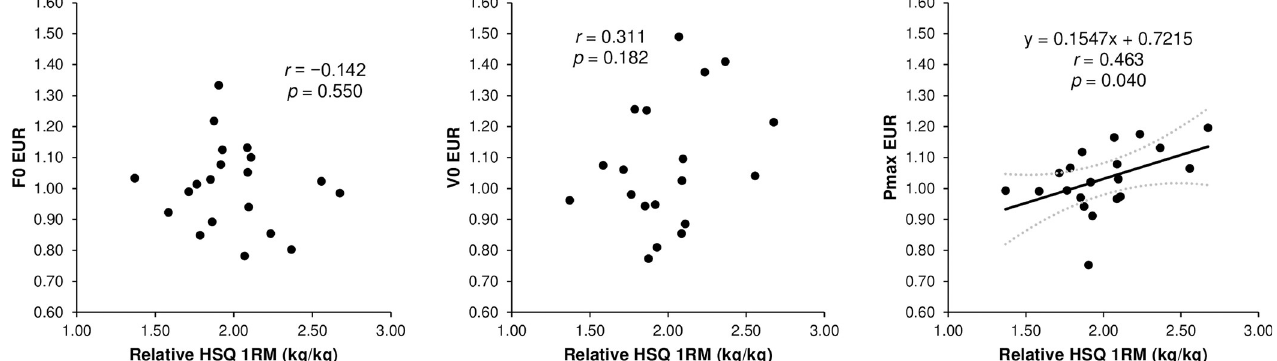
Fig 3. Associations (line-of-best-fit ± 95% confidence intervals) of the maximum strength (relative half squat one-repetition maximum) with the eccentric utilization ratio (EUR) of the theoretical maximum force (F0), velocity (V0), and power (Pmax).